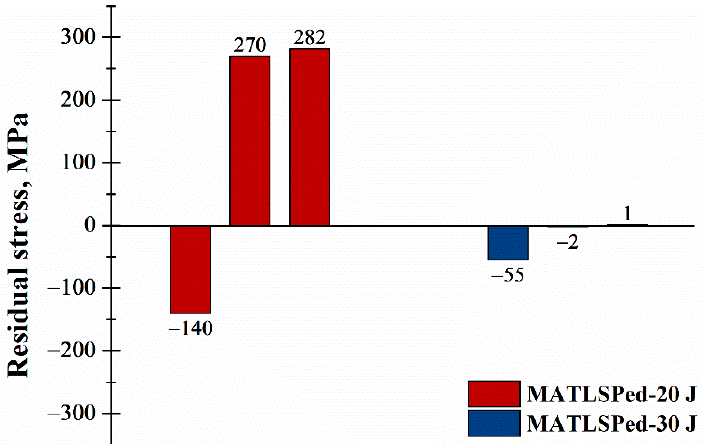
Figure 9. Residual stress measured on MATLSPed-20 J and MATLSPed-30 J specimens after milling down 50 μ m from the original peened surface.